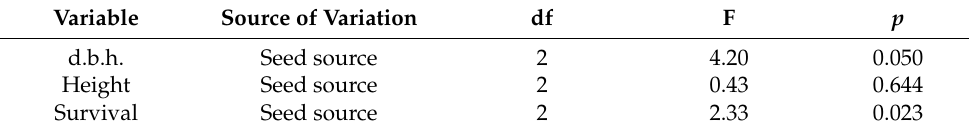
Table 7. Comparison of average d.b.h., total height, and survival among shortleaf pine seed sources (provenance) across all measured test sites; means with the same letter are not significantly different ( p > 0.05).